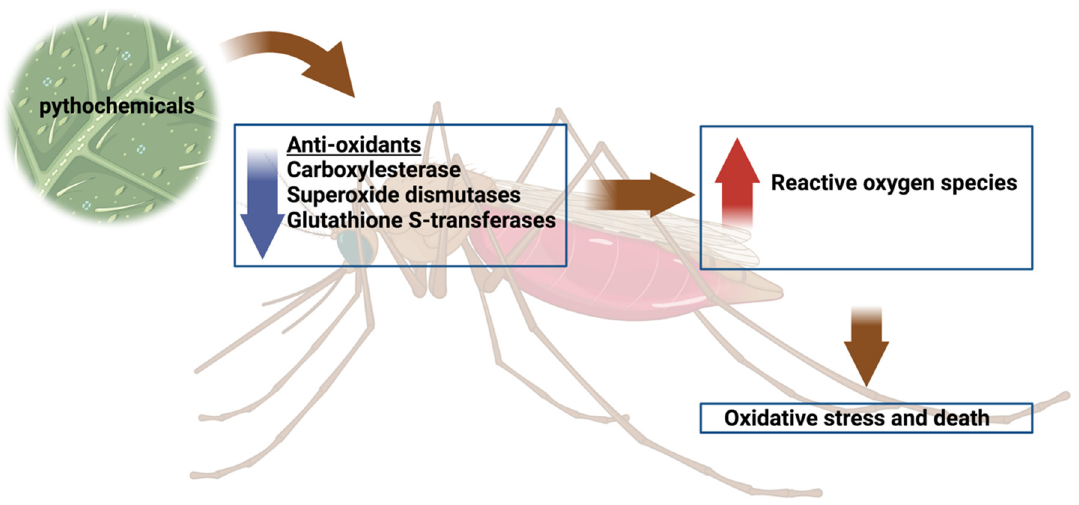
Figure 2. Schematic diagram on the activity of the phytochemicals and its possible mode of activity to cause mortality. Created with Biorender.com (accessed on 10 May 2022).